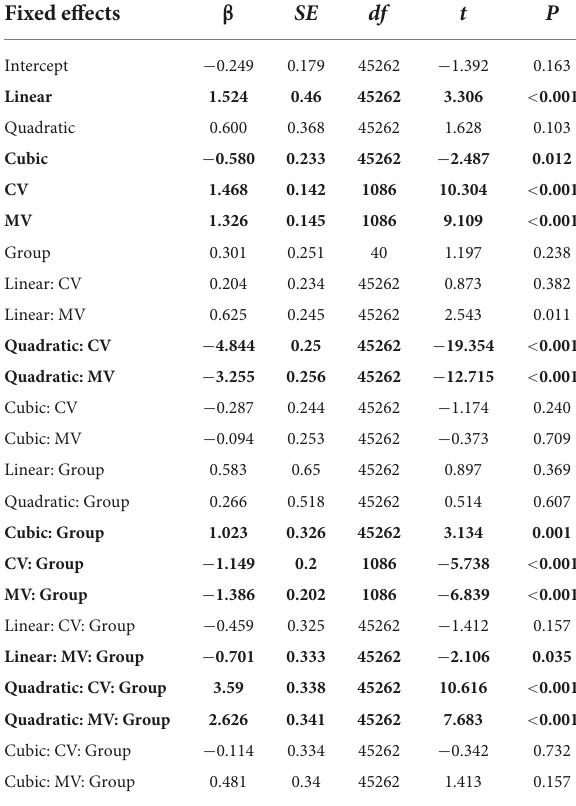
TABLE 4 Growth curve analysis for DS and TD